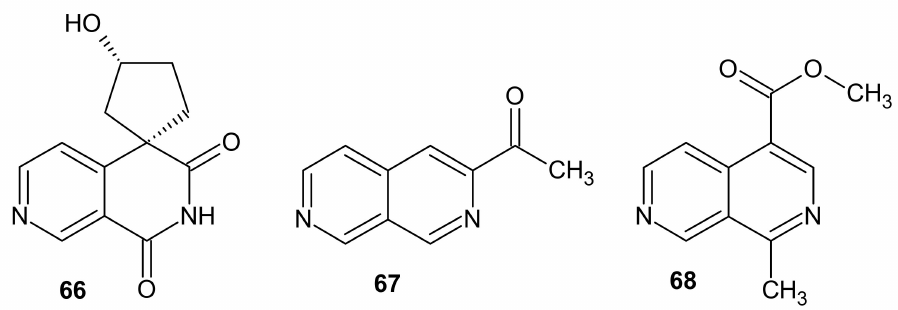
Figure 22. Sesbanine 66 , 3-acetyl-2,7-naphthyridine 67 , and neozeylancine 68 . 3-Acetyl-2,7-naphthyridine 67 (Figure 22) was isolated by Janot et al. [94] from the tranquilizer activity [94].